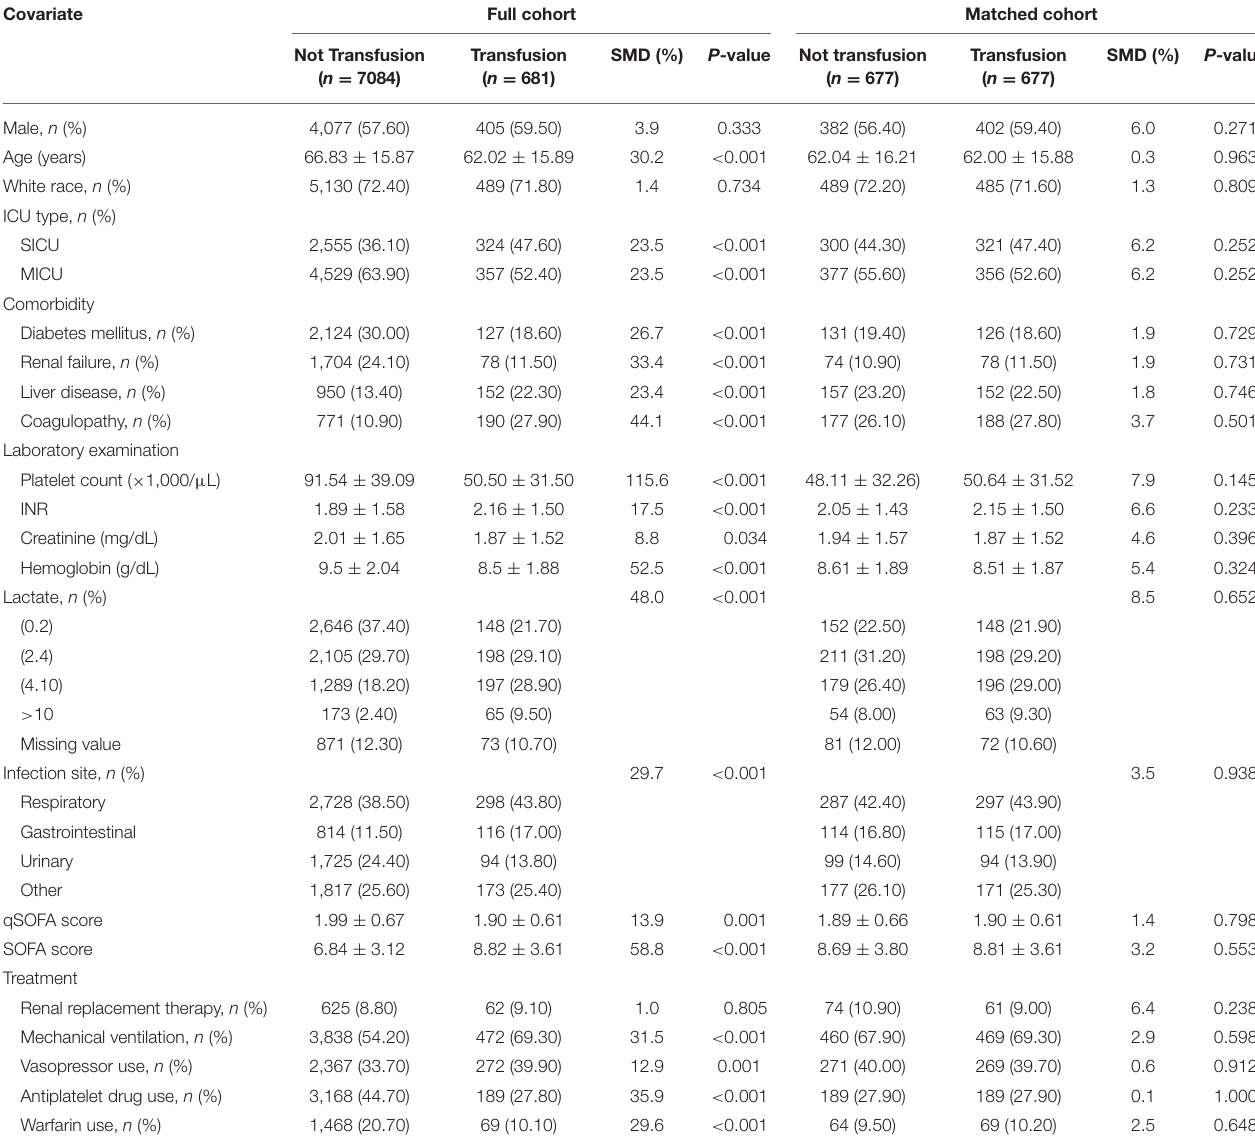
TABLE 1 | Baseline characteristics of patients in the full cohort and propensity score matched groups.